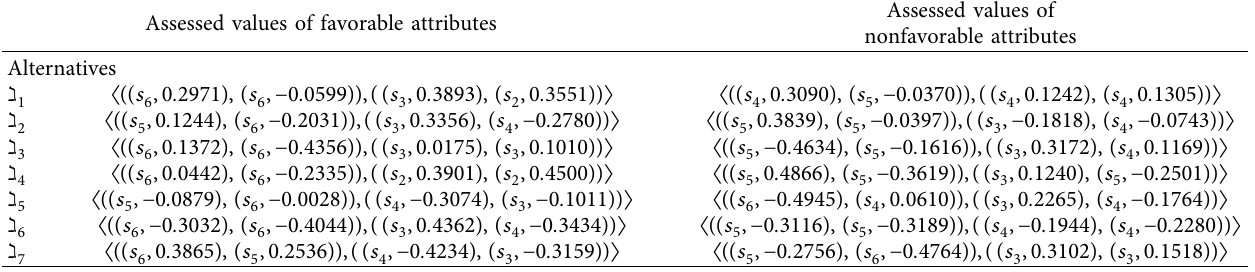
Table 9: Assessing values of favorable- and nonfavorable-type attributes by the 2TLC q -ROFHWG operator. Assessed values of favorable attributes